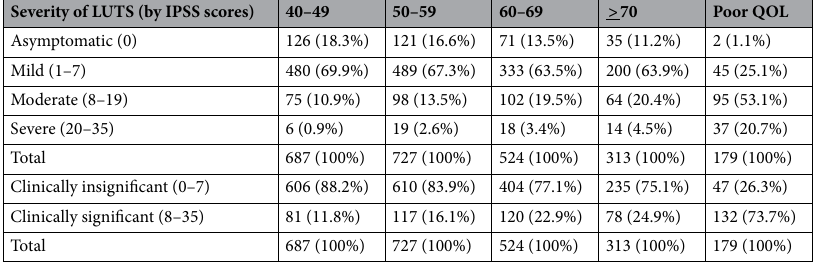
Severity of LUTS (by IPSS